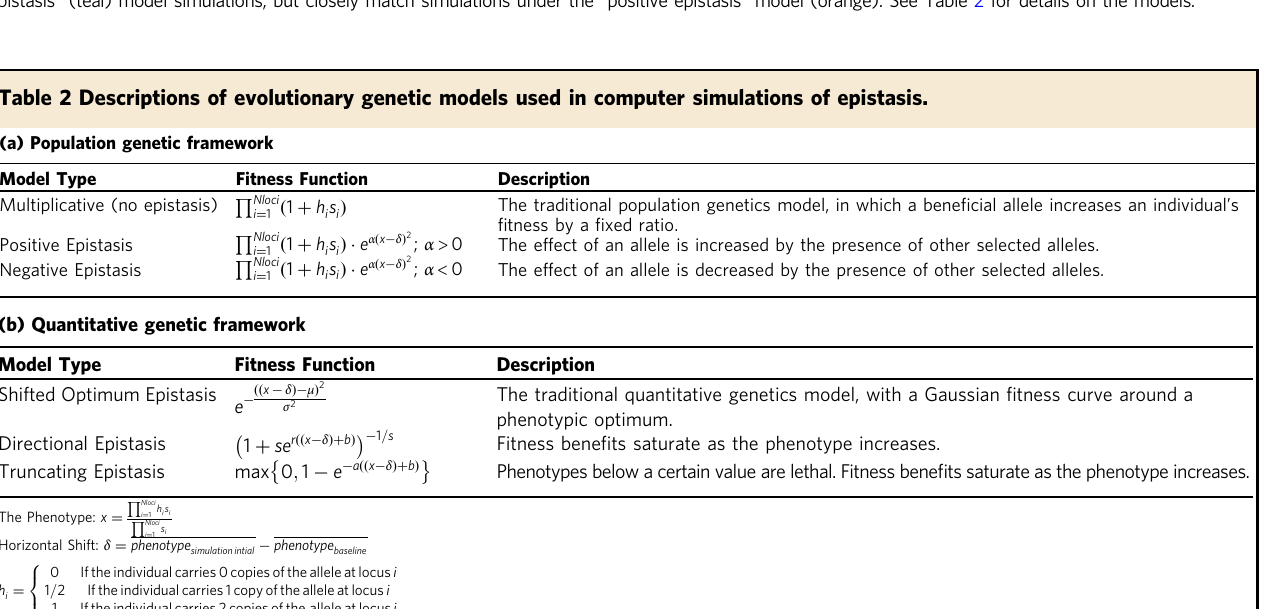
Fig. 2 Genomic parallelism across replicate treatment lines during laboratory selection. a Pairwise overlap (Jaccard index) of selected alleles between experimental replicate lines (dotted brown lines) relative to simulations (box plots). Box plots display median (middle line), 25th and 75th percentile (box), 5th and 95th percentile (vertical line), and data beyond the 5th and 95th percentile (single points) of mean Jaccard indices at generations six (dark blue) and ten (yellow) from 1000 simulation iterations. Empirical values most closely match those of data simulated under the “ positive epistasis ” model with an α parameter of 36.5 (generation six: P = 0.69; generation ten: P = 0.58), and are signi fi cantly higher than those simulated under the standard population genetic “ multiplicative fi tness ” model ( P = 0) and the quantitative genetic “ directional epistasis ” model ( P = 0), based on N = 1000 simulations for each model. The “ multiplicative fi tness ” model provides a null expectation for parallelism given the allelic selection coef fi cients and effective population sizes. b Relationship between number of loci contributing to the adaptive response and levels of parallel evolution. For 100 simulation iterations, we calculated the mean Jaccard index between simulated populations and display the mean (triangle and circle points) and interquartile range (vertical lines and shaded area) of Jaccard indices across simulation iterations. Epistatic models (Table 2), particularly quantitative fi tness models, predict that the degree of parallelism among replicate lines increases as the number of loci contributing to an adaptive response declines. Levels of parallelism in our real data (horizontal dotted lines) can be replicated either by reducing the number of effective alleles in the “ directional epistasis ” model (teal) or increasing the α parameter of the “ positive epistasis ” model (orange). c The distribution of selected alleles in terms of the proportion of replicate lines in which the selected allele experienced a signi fi cant frequency shift at generation ten (i.e., “ Replicate frequency spectrum ” ref. 41 ). A far greater proportion of replicate lines show higher proportions of the selected alleles in the empirical data (brown) than in the “ multiplicative ” (green) or “ directional epistasis ” (teal) model simulations, but closely match simulations under the “ positive epistasis ” model (orange). See Table 2 for details on the models.